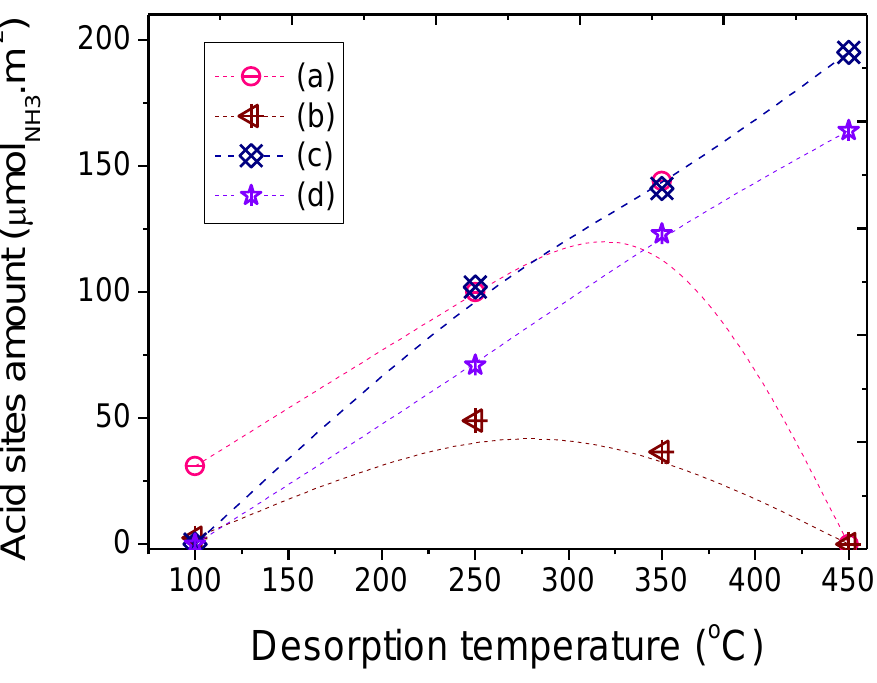
Figure 5. Acid sites amount in function of the desorption temperature of the catalysts: ( a ) Nb 2 O 5 , ( b ) CoMo/Nb 2 O 5 , ( c ) PtMo/Nb 2 O 5 and ( d ) NiMo/Nb 2 O 5.